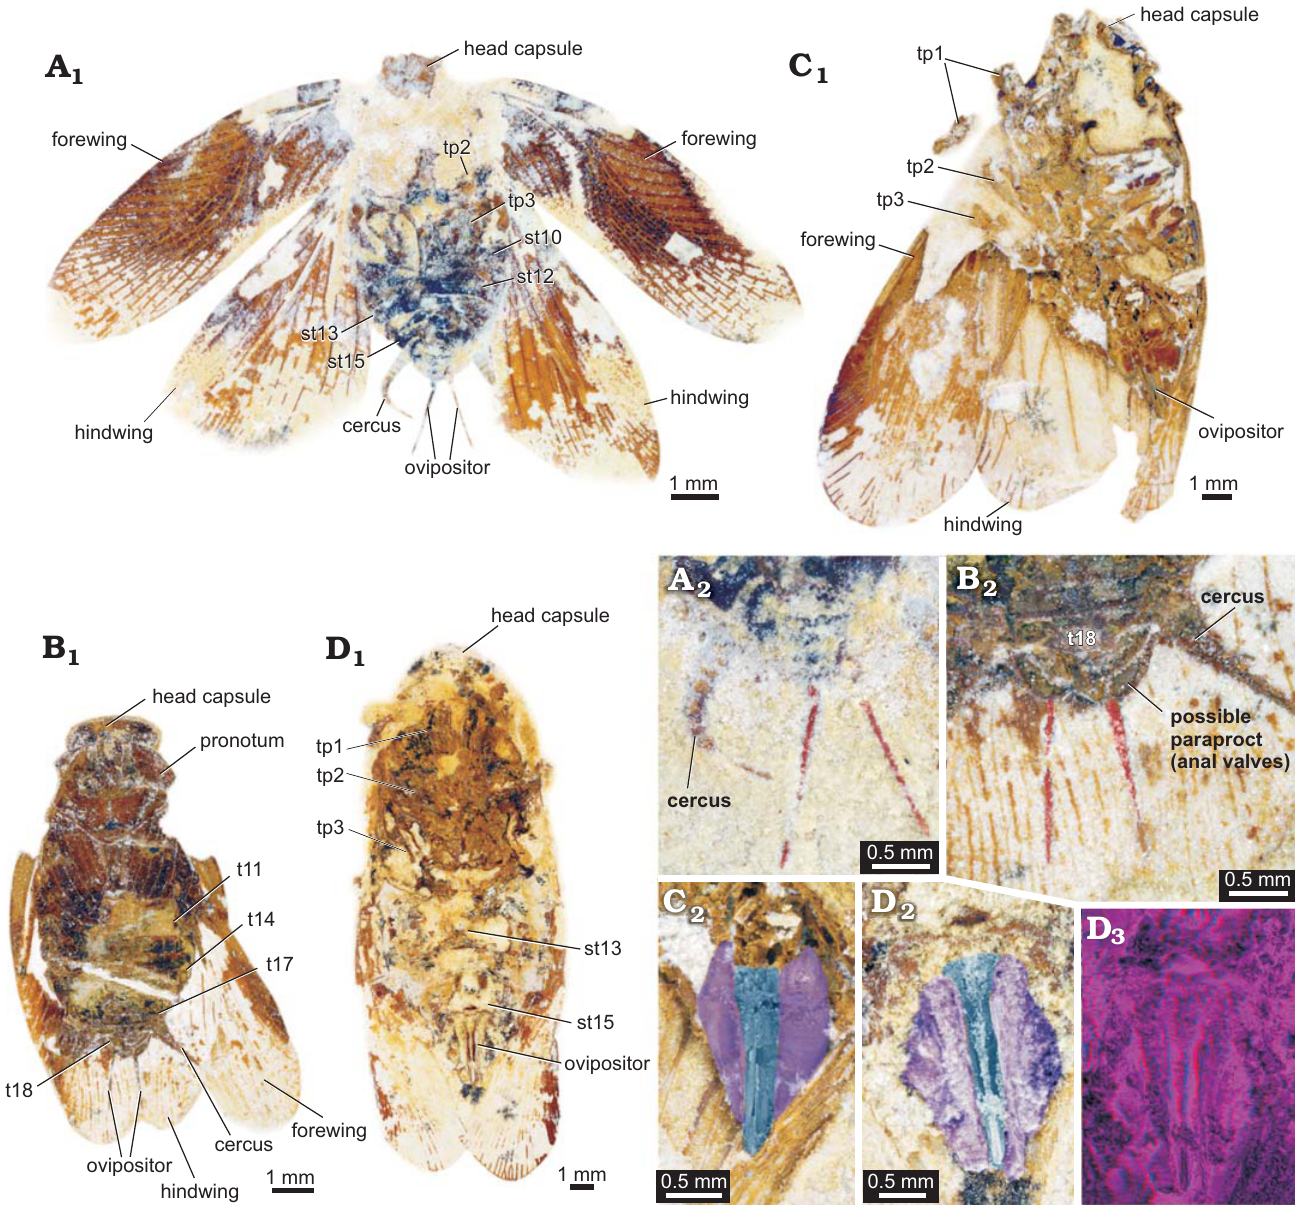
Fig. 11. Undescribed cockroaches or roachoids from the Aptian, Cretaceous Crato Formation of Brazil; with interpretations of preserved structures. A . ROMIP64635 in ventro-lateral view. B . ROMIP64634 in dorsal view. C . ROMIP64636 in ventral view. D . ROMIP64638 in ventral view. A 1 –D 1 , overviews; A 2 –D 2 , colour-marked close ups of the ovipositor (red, undeterminable valves; blue, valves 2; purple, valves 3); D 3 , red-cyan stereo-anaglyph (please use red-cyan glasses to view). Abbreviations: st10–15, sternite of post-ocular segment 10–15 (abdominal segment 2–7); t11–18, tergite of post- ocular segment 11–18 (abdominal segment 3–10); tp1–3, thoracopod 1–3 (pro-, meso-, and metathoracic